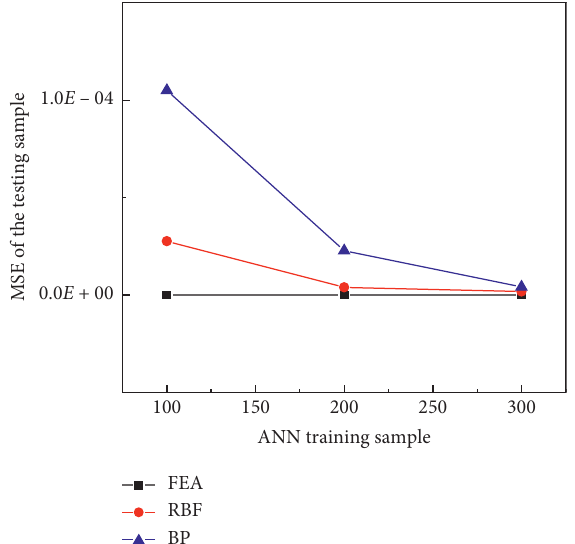
Figure 13: Comparison of the change of MSE between RBF and BP as the ANN sample data size change.